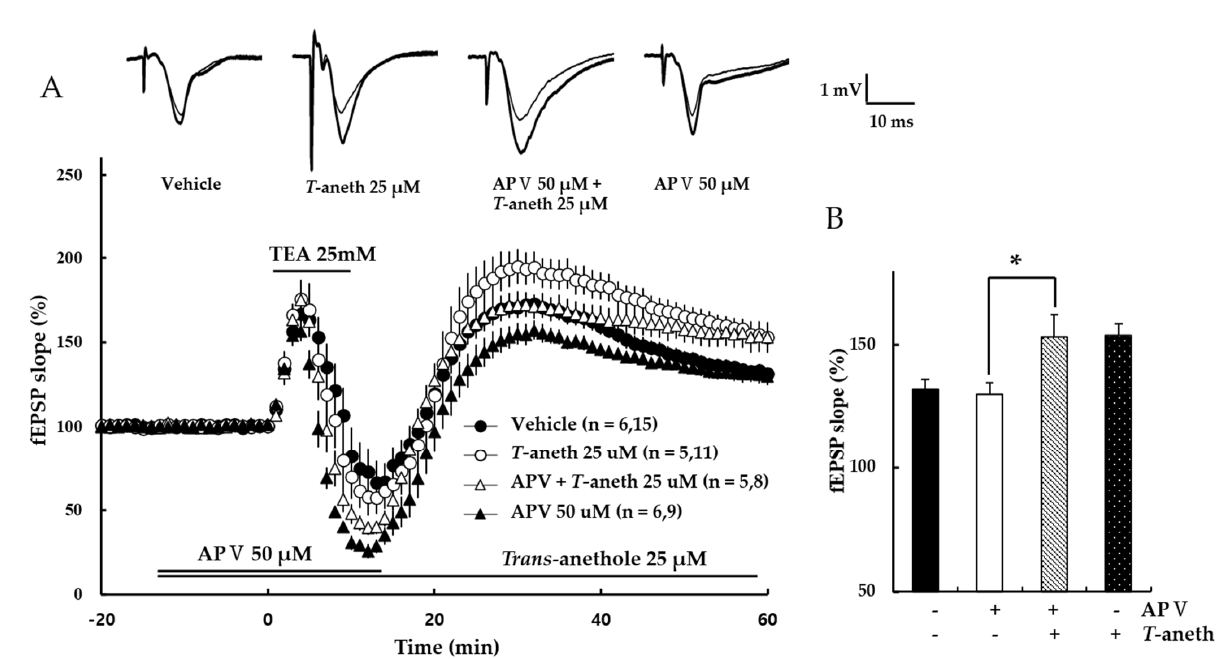
Figure 4. An NMDA receptor antagonist does not affect TEA ‐ induced LTP induction. ( A ) NMDA receptor ‐ independent LTP was induced by TEA. APV (50 μ M) and TEA (25 mM) were applied during the time periods indicated by the bars, and then washed out. ( B ) Values represent percent changes observed in the fEPSP slope at 58–60 min after TEA exposure. The numbers of mice and slices, respectively, are shown in parentheses. Filled circles, open circles, open triangles, and filled triangles indicate the Vehicle group, 25 μ M Trans ‐ anethole group, 50 μ M APV + 25 μ M Trans ‐ anethole group, and 50 μ M APV group, respectively. Statistical significance (* p < 0.05 vs. Vehicle) was calculated by one ‐ way ANOVA followed by Tukey HSD test. T ‐ aneth, Trans ‐ anethole; APV, DL ‐ APV; fEPSP, field excitatory synaptic potential.